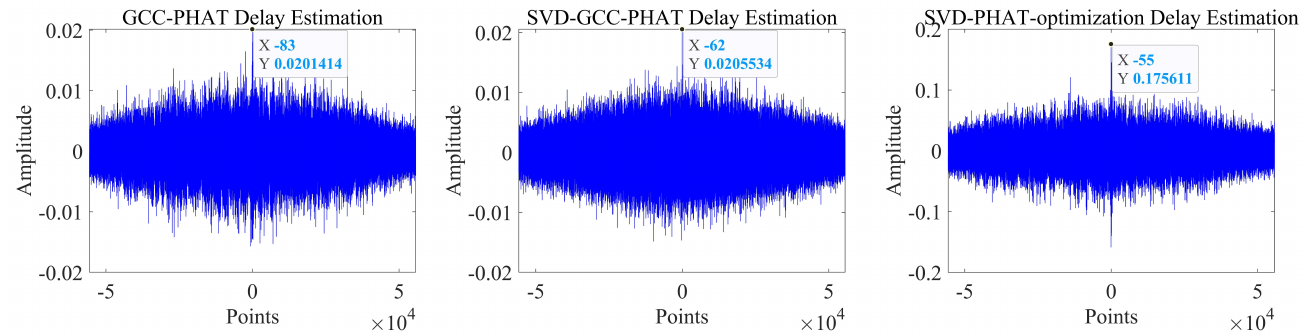
Figure 7. Comparison of delay estimation peak values of three methods when SNR = − 20.